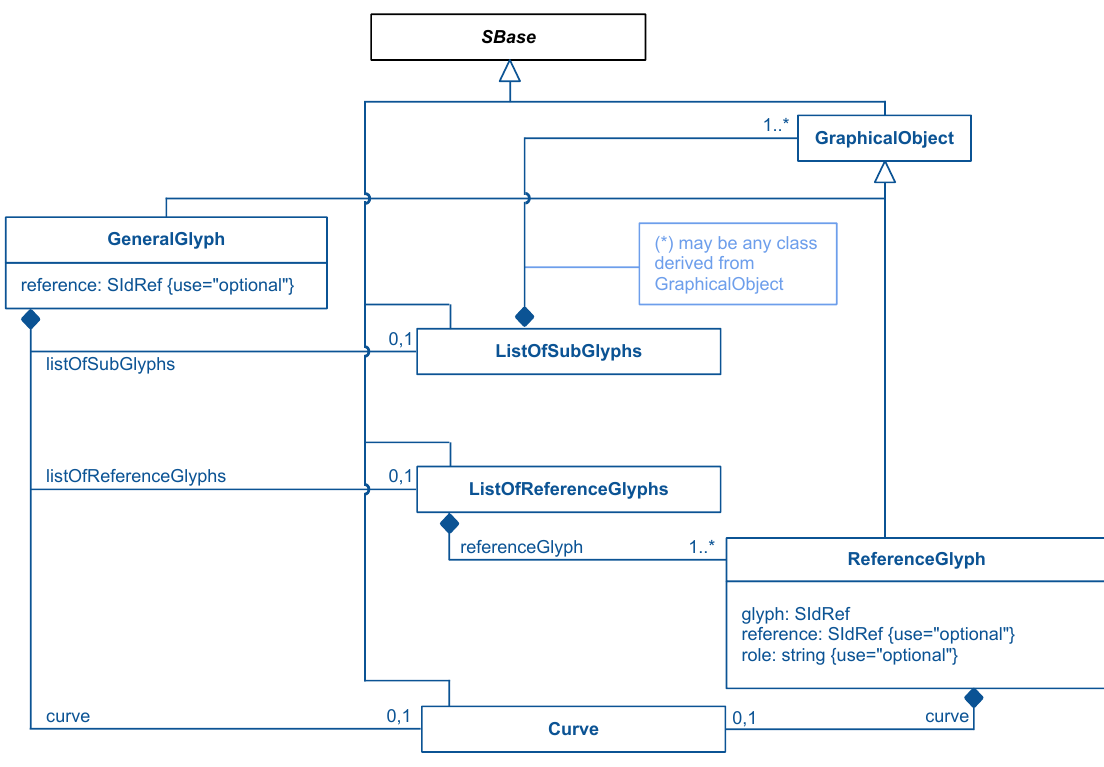
Figure 13: The definitions of the GeneralGlyph